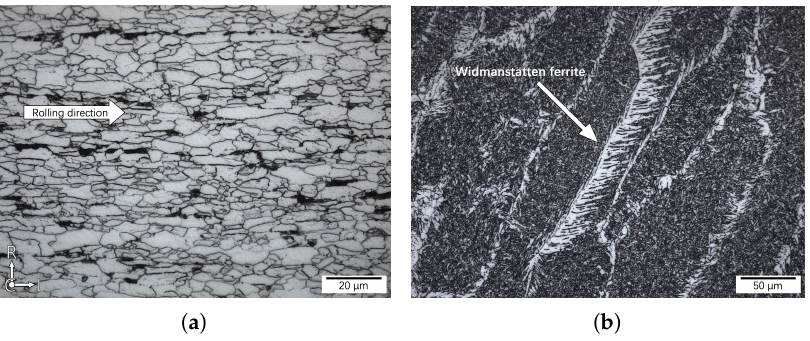
Figure 2. ( a ) Microstructure of the base metal exhibiting polygonal ferrite (white) and colonies of pearlite (black) elongated extending along the rolling direction (white arrow). ( b ) Microstructure of the weld metal exhibiting fine-interlocking grains of acicular ferrite with Widmanstätten ferrite structures emanating from prior austenite grain boundaries. Etchant: nital